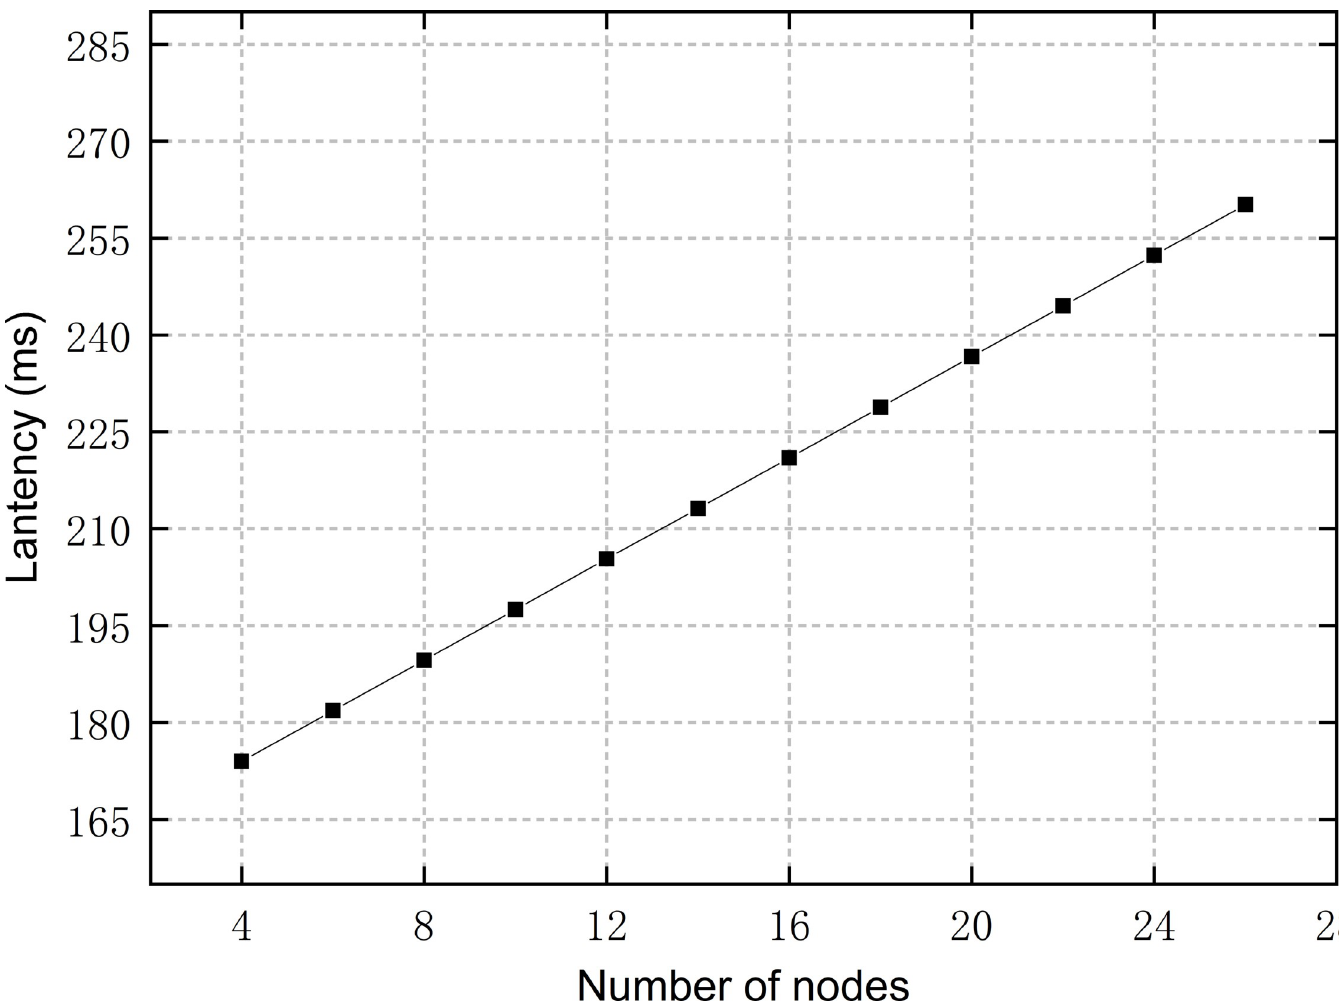
Fig 10. Latency of authentication at different numbers of